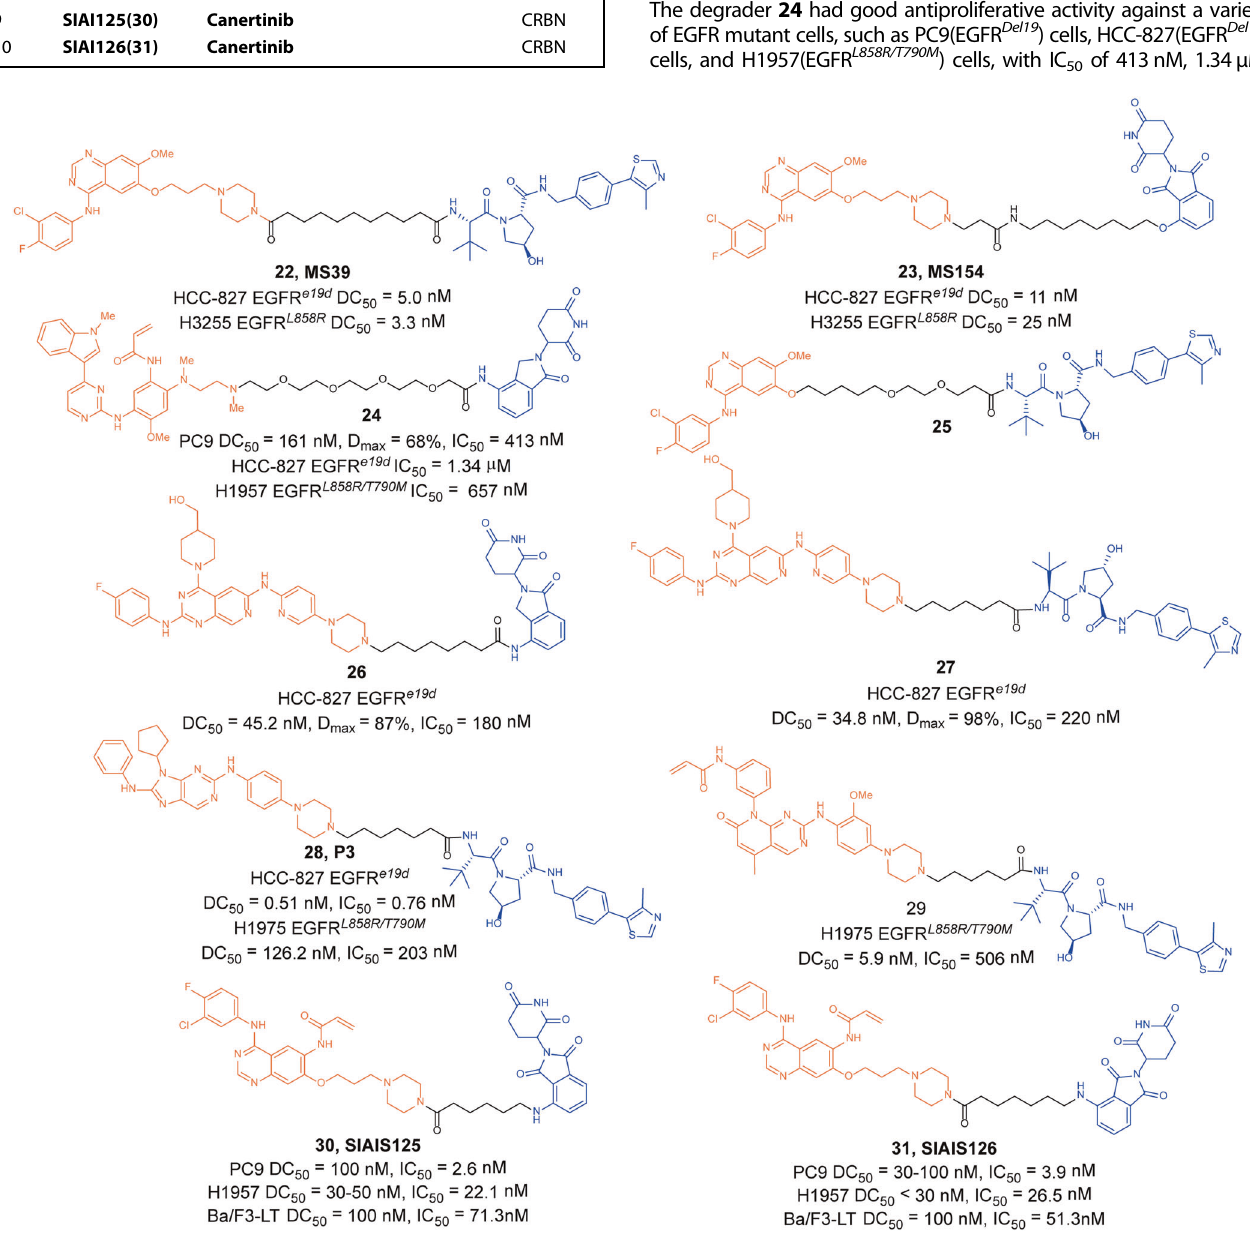
Fig. 7 The representative PROTACs targeting EGFR Signal Transduction and Targeted Therapy (2022)